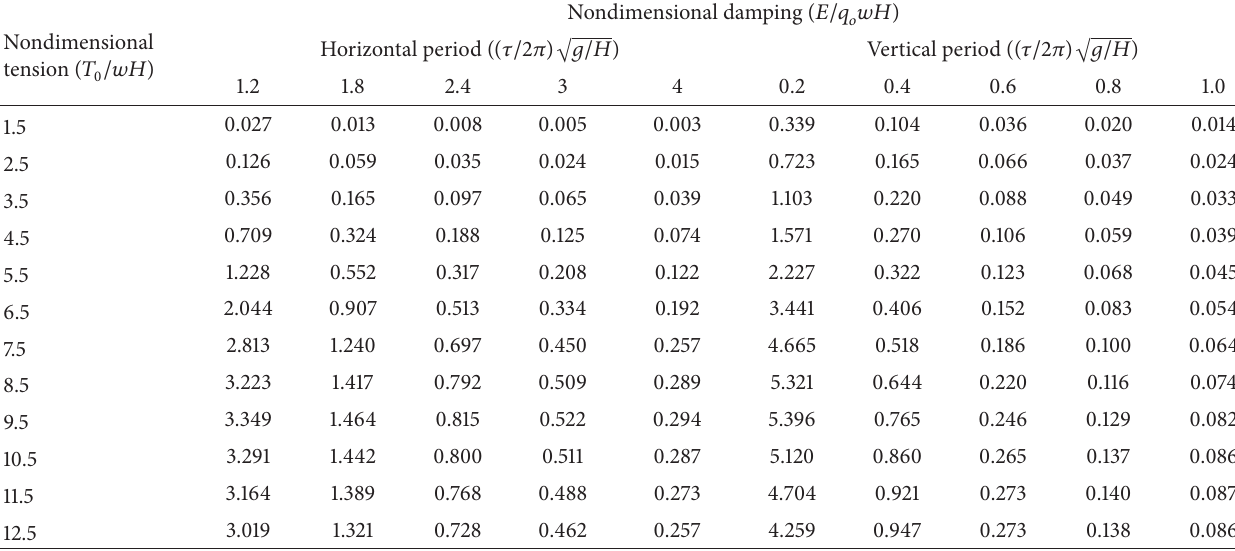
Table 4: Mooring line damping estimation under different excitation